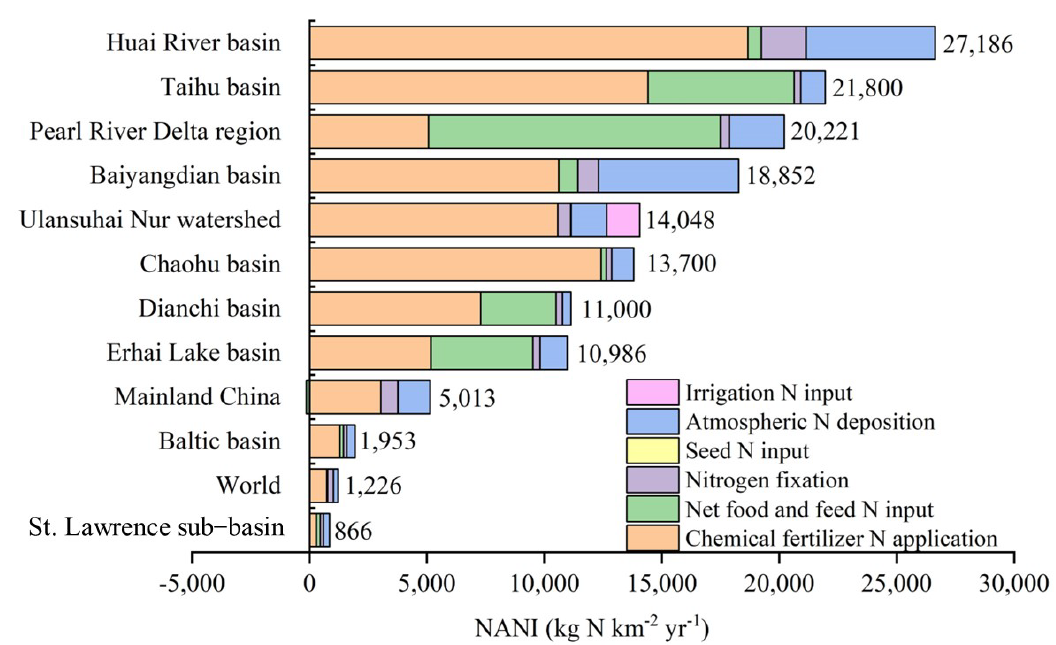
Figure 8. NANI values and its components in major watersheds and countries worldwide.